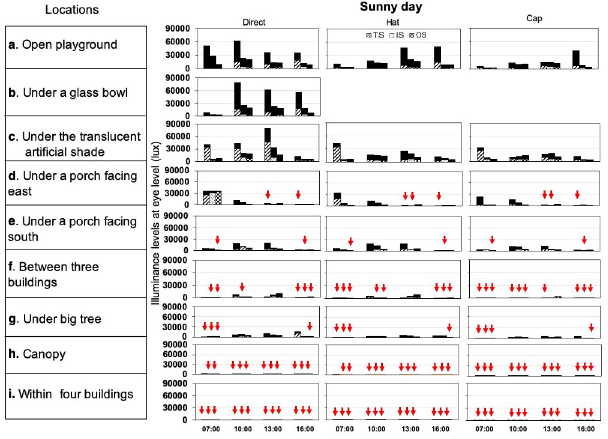
Fig 2. Illuminance levels recorded under direct source, hat and with a cap on two sunny days. TS, IS and OS sensor source positions recorded in four different time points of a day (07:00–08:00, 10:00–11:00, 13:00–14:00 and 16:00– 17:00 hours). The dark shaded area on the top of each bar represents the difference in illuminance levels obtained on two different sunny days. The downward-facing arrows in red colour represent illuminance levels < 1000